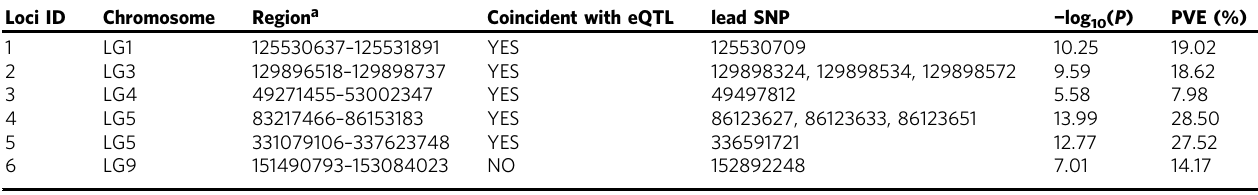
Table 1 Summary of SNPs associated with the leaf color at the suggestive threshold Loci